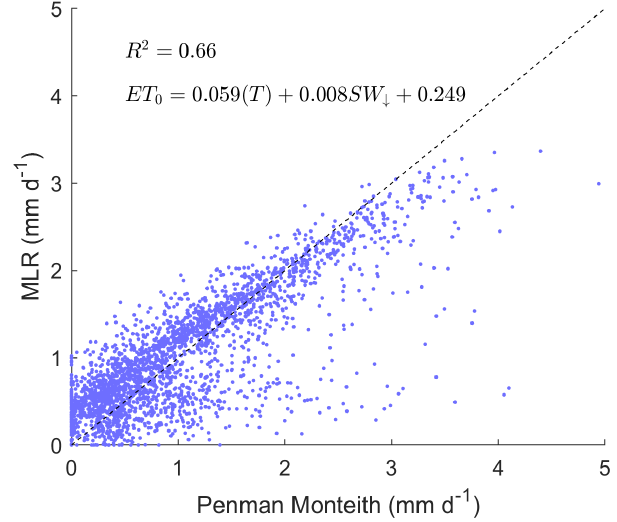
Figure A1. Multiple linear regression model used to convert ambi- ent air temperature and incoming solar radiation into potential evap-